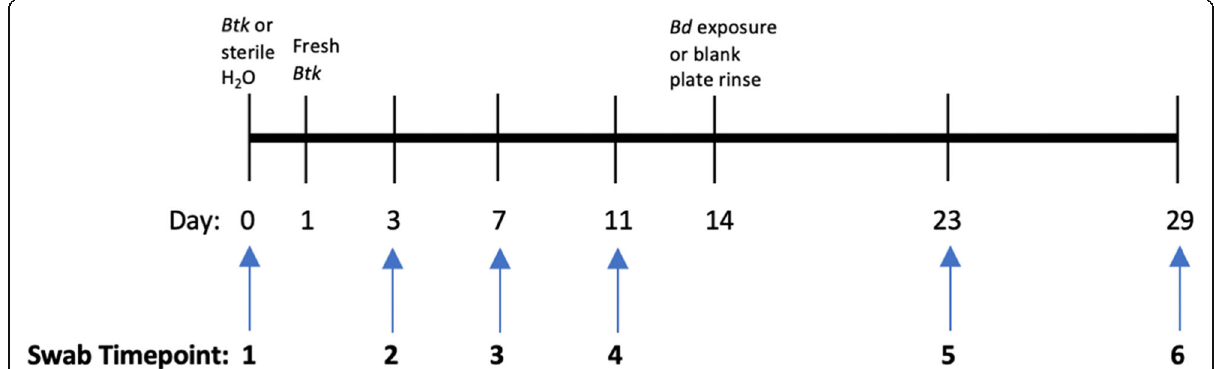
Fig. 1 Timeline for bacteria ( Btk ) exposures and Bd exposures. Timepoints for swabs are also included